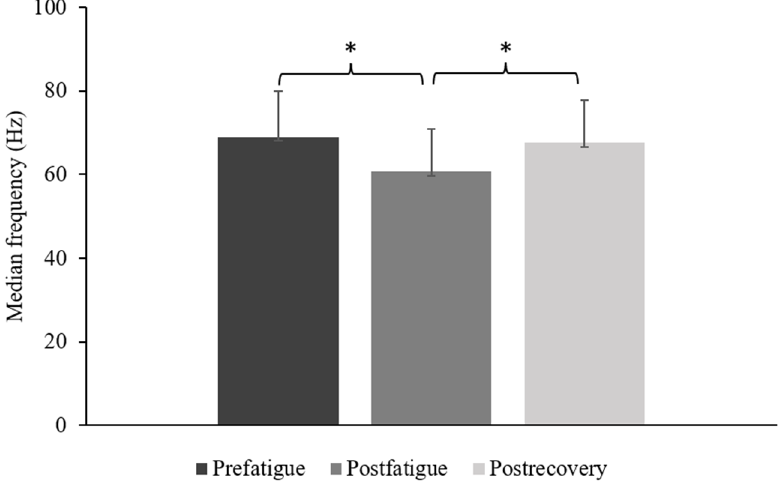
Figure 3. Comparison of the FDS median frequency among the prefatigue, postfatigue, and postre- covery states. (* p < 0.05).